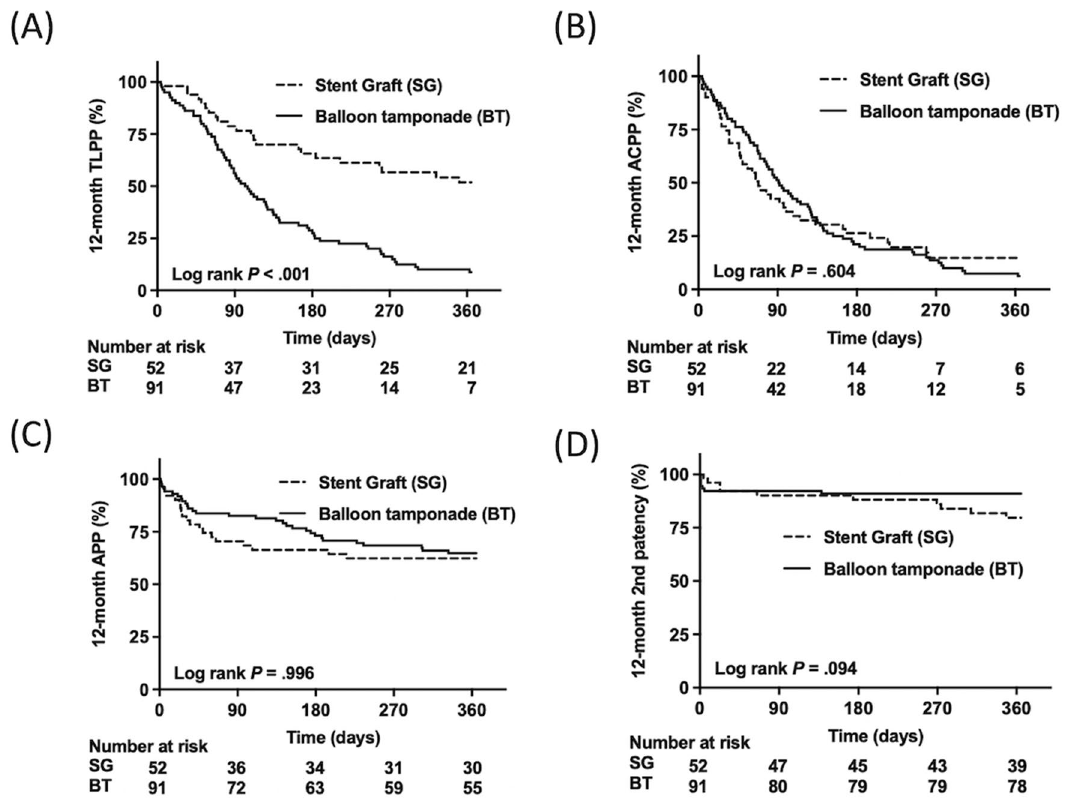
Figure 2. Kaplan–Meier plots of the cohort until 12 months: ( A ) target lesion primary patency, ( B ) entire access circuit primary patency, ( C ) access circuit assisted patency, and ( D ) secondary patency after the interventions. SG stent graft, BT balloon tamponade, TLPP target lesion primary patency, ACPP access circuit primary patency, APP access circuit assisted